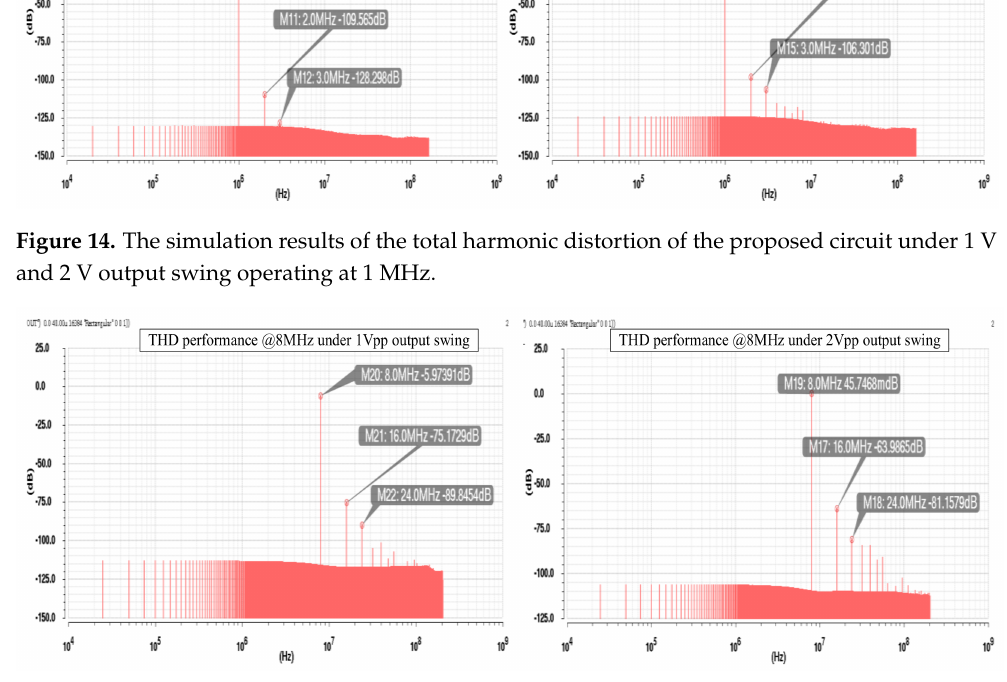
Figure 15. The simulation results of the total harmonic distortion of the proposed circuit under 1 V and 2 V output swing operating at 8